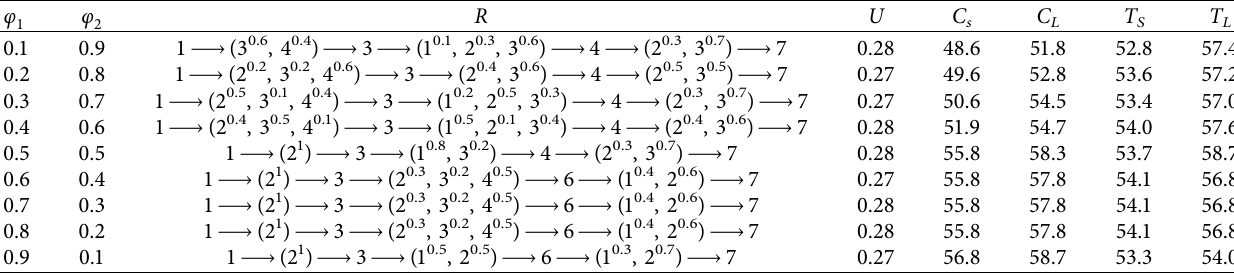
Table 7: The impact of φ